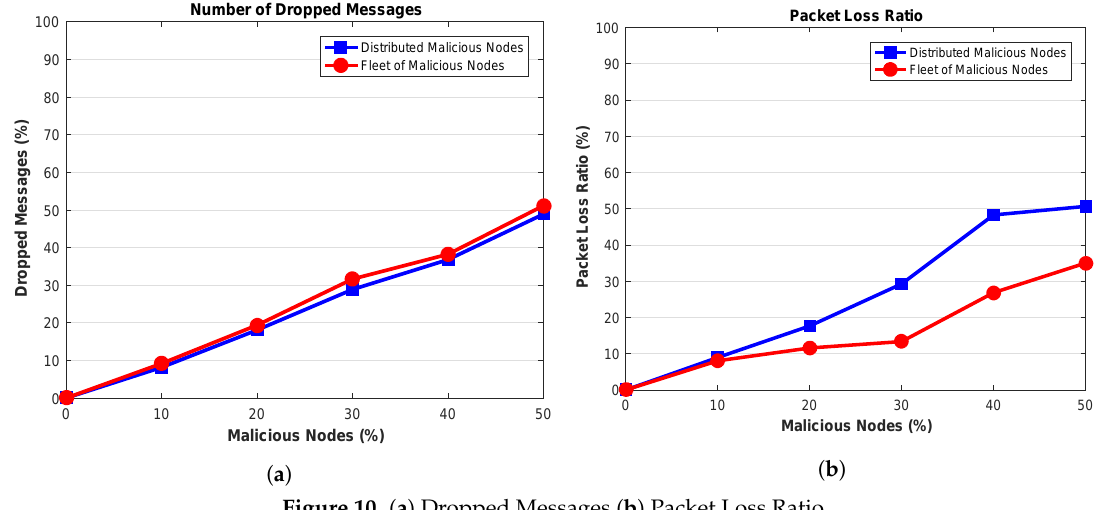
Figure 10. ( a ) Dropped Messages ( b ) Packet Loss